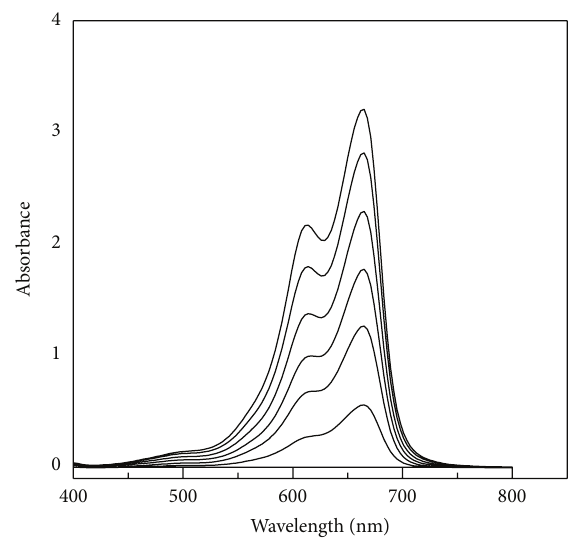
Figure 9: Raman spectra of the samples prepared at different reaction temperatures: (a) 110 ∘ C, (b) 130 ∘ C, (c) 150 ∘ C, and (d) 180 ∘ C.